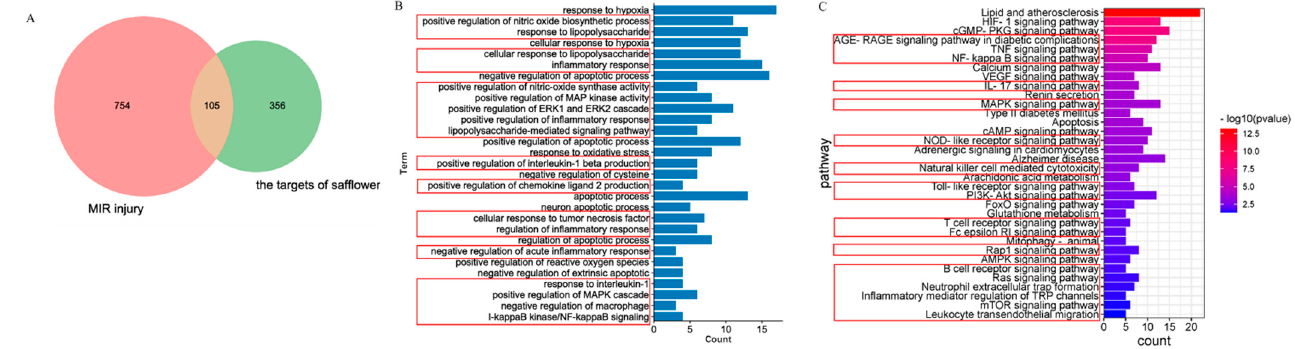
Figure 4. Venn diagram of drug targets and disease genes ( A ) are shown. GO ( B ) and KEGG ( C ) enrichment analysis of safflower in the treatment of MIR injury are shown. The terms labeled by using red boxes were associated with inflammation.